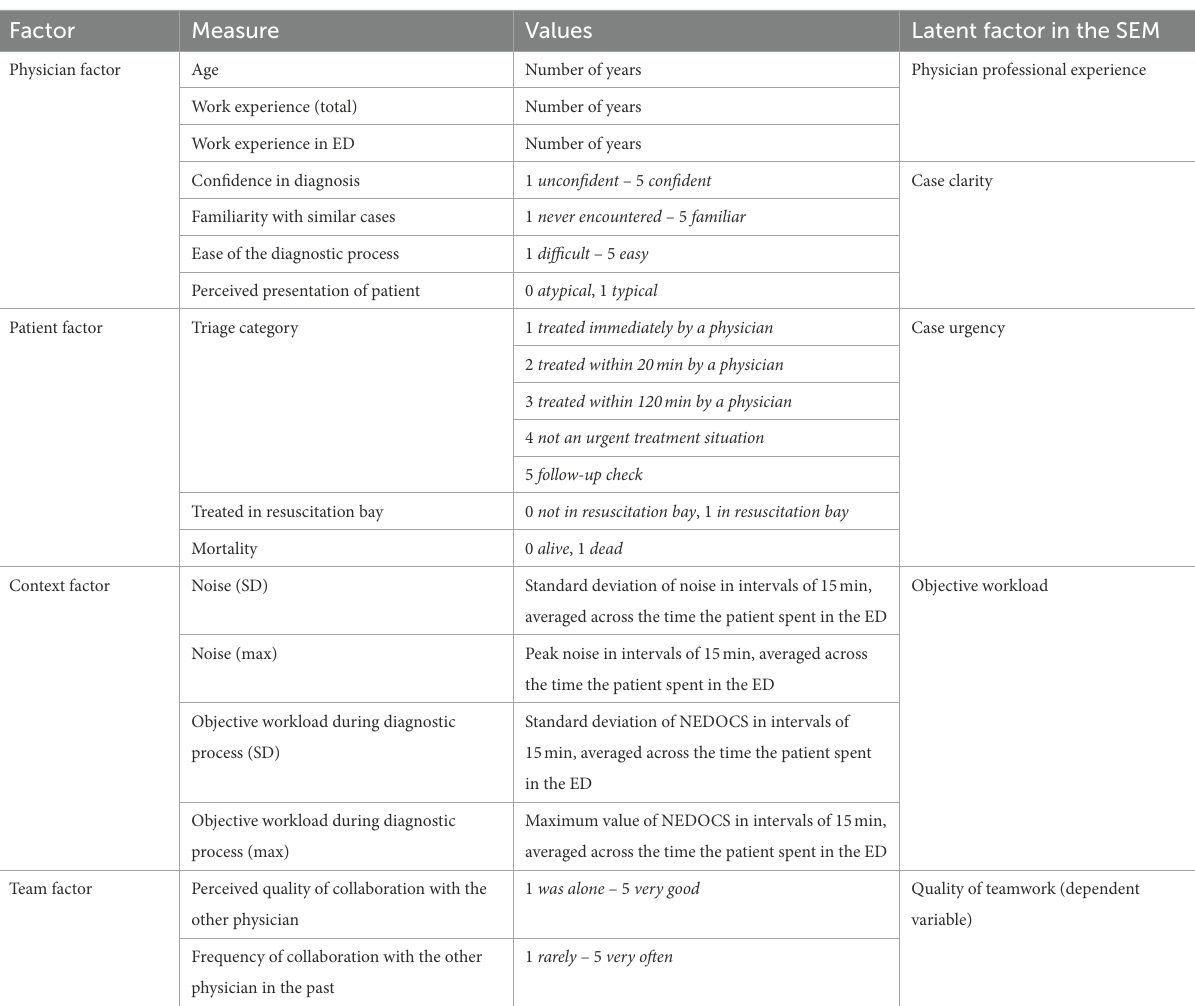
TABLE 1 Overview of collected data and how they were summarized into latent factors.